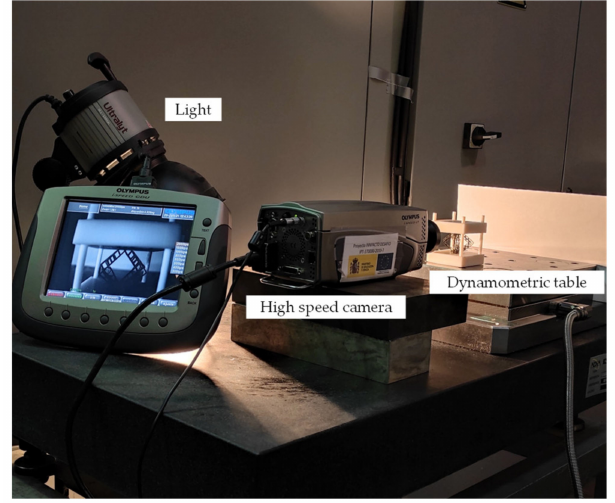
Figure 12. Experimental measuring